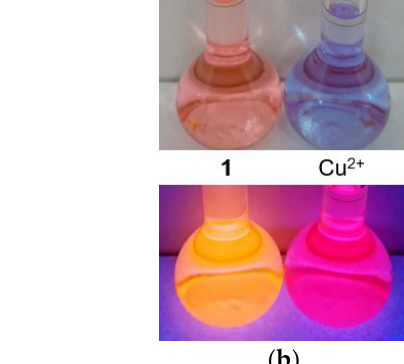
( b ) Figure 5. ( a ) Job’s plot of BODIPY 1 and Cu 2+ system. The total concentration of BODIPY 1 and Cu 2+ was 9 µM and absorbance at 593 nm (A 580 ) was plotted. ( b ) Plot of fluorescence intensity at 620 nm ( F 620 ) and ratio of fluorescence intensities ( F 620 / F 580 ) of BODIPY 1 (3 µM) versus increasing Cu 2+ concentration (0–30 µM) in acetonitrile. The excitation wavelength was 550 nm. The selectivity of BODIPY 1 for Cu 2+ was investigated (Figure 6a). Co 2+ , Ni 2+ , Zn 2+ , Cd 2+ , and Hg 2+ did not increase the fluorescence intensity at 620 nm, which originated from the complex of BODIPY 1 with Cu 2+ . Addition of the cations, therefore, did not cause F 620 / F 580 to increase. However, when Cu 2+ was added to these solutions, F 620 increased and therefore F 620 / F 580 increased. This Cu 2+ selectivity might be a result of the interaction of BODIPY-bis(pyridin-2-ylmethyl)amine conjugate and Cu 2+ , which has a low-lying d–d state nature [10]. Among these cations, Fe 3+ is the main interfering cation in the use of BODIPY 1 as a Cu 2+ fluorescent sensor, because the fluorescence spectrum of the solution containing 10 equiv of Fe 3+ overlaps with that of the solution containing Cu 2+ . The absorption spectra shown in Figure 2a also suggest the formation of the complex of BODIPY 1 and Fe 3+ . Therefore, some kind of pretreatment for Fe 3+ removal would be necessary for Cu 2+ sensing with BODIPY 1 . Fe 3+ also has a paramagnetic nature, and interfering effects for Cu 2+ sensors were often reported [21–23]. To investigate the possibility of practical application for Cu 2+ screening with BODIPY 1 , we used tap water (pH = 7.4, electrical conductivity=19.7 mS/m) as a real sample. Cu 2+ was spiked with tap water, and the concentration of Cu 2+ was adjusted to 30 ppm (470 µM), which is ten-times higher than the